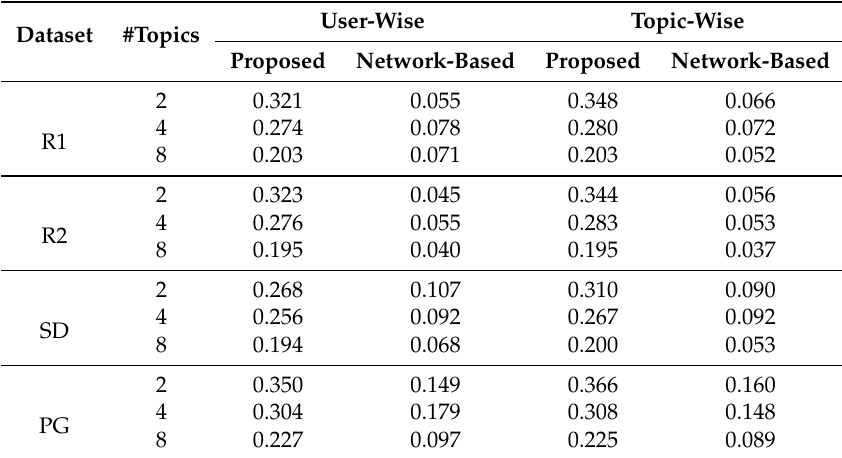
Table 7. Standard deviation of topic probability distribution of users.